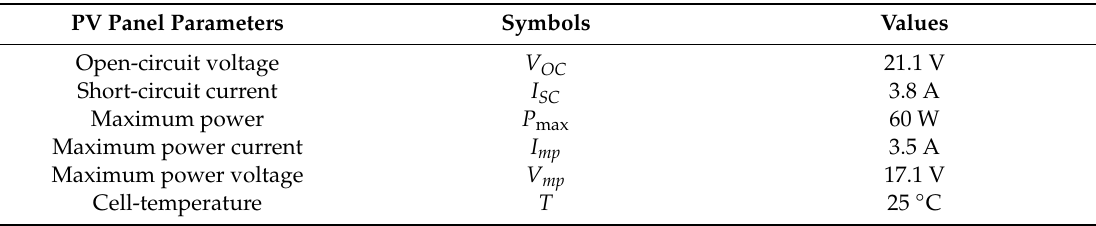
Table 1. The disclaimers of the Solarex (MSX60) photovoltaic module [26].